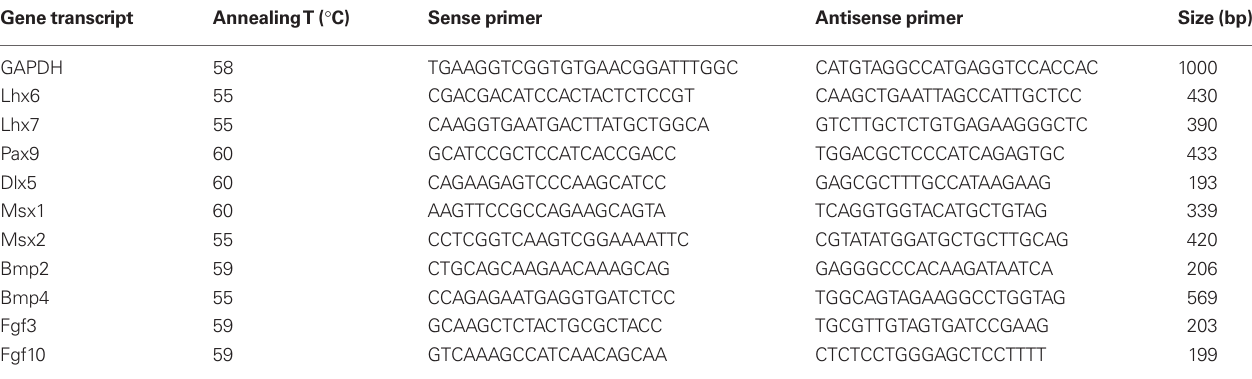
Table 1 | Sequences of the primers used in RT-PCR analysis, size of the amplified products and annealing temperatures. Gene